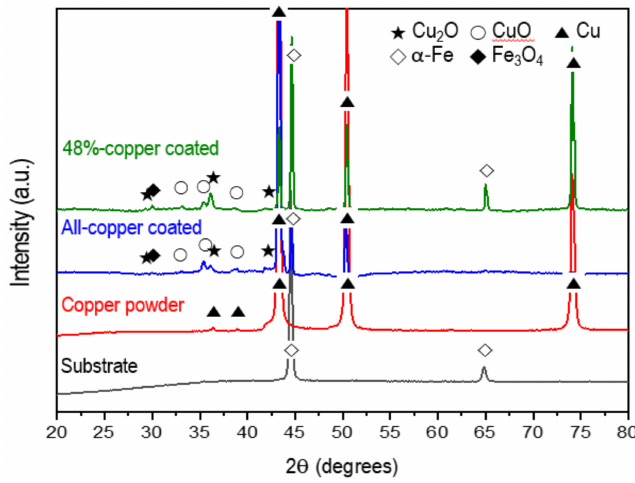
Figure 4. XRD patterns for specimens.